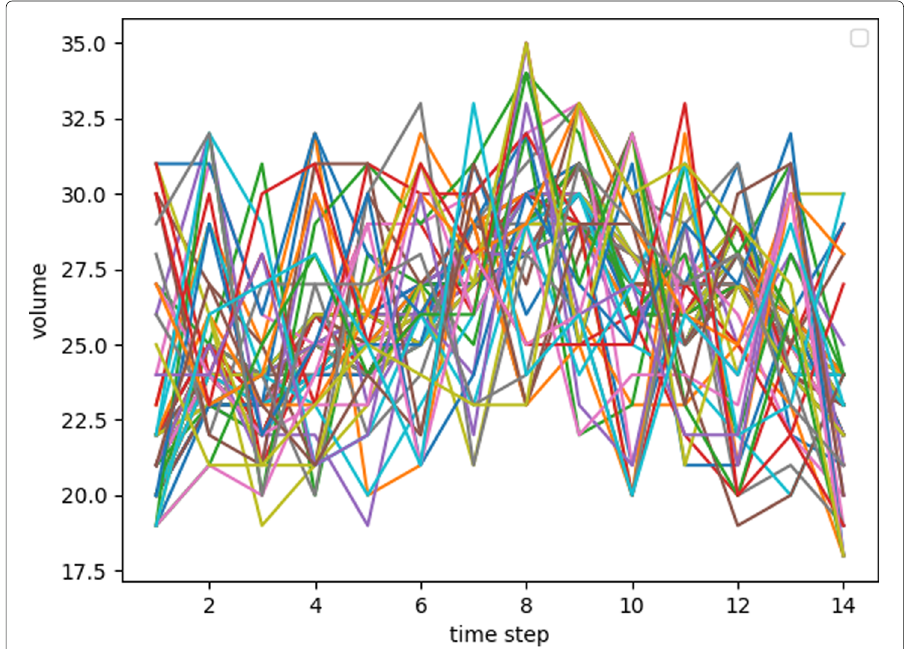
Fig. 5 Volume overtime for all the large components. Most components have a volume of 20 to